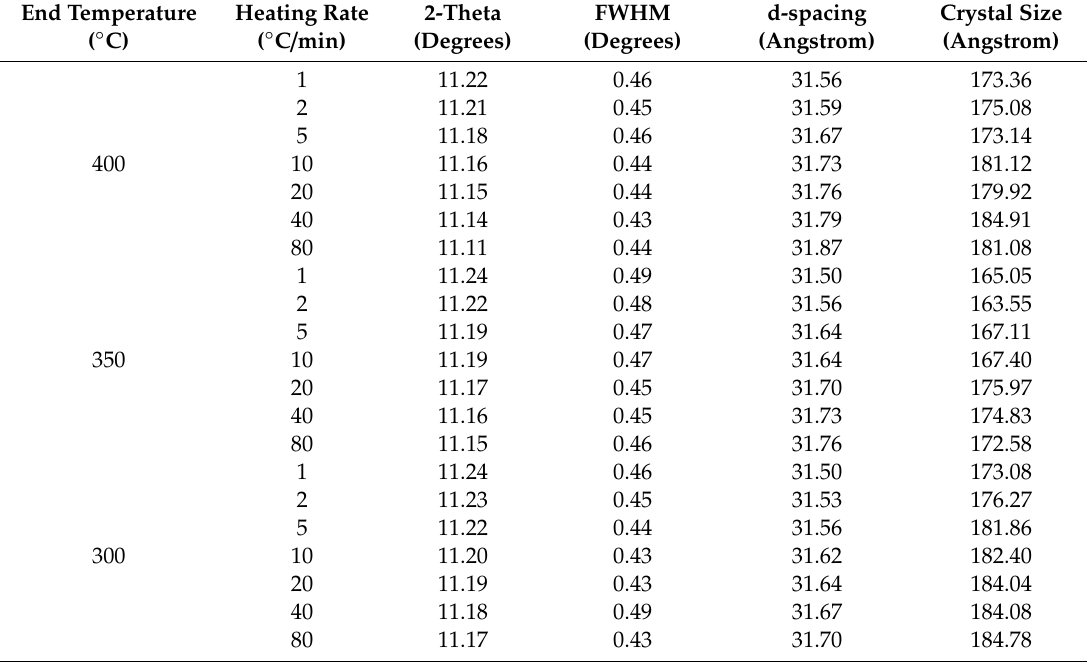
Table 1. D-spacing, crystal size and orientation factors calculated using the (004) di ff raction for PI fibers obtained at 300, 350 and 400 ◦ C under di ff erent heating rates.